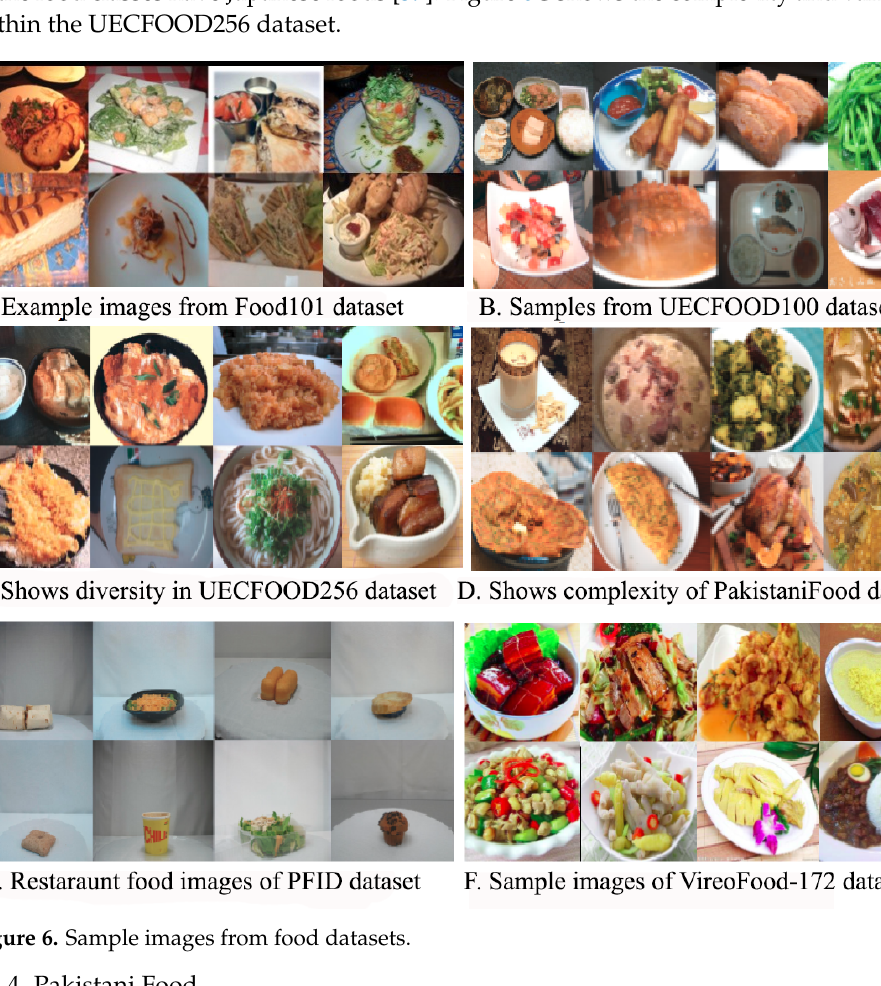
Figure 6. Sample images from food